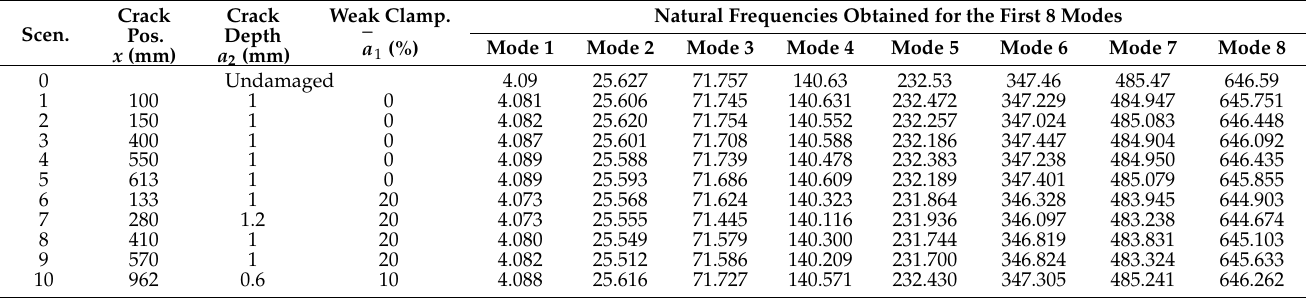
Table 3. Obtained natural frequencies for the defined damage scenarios.